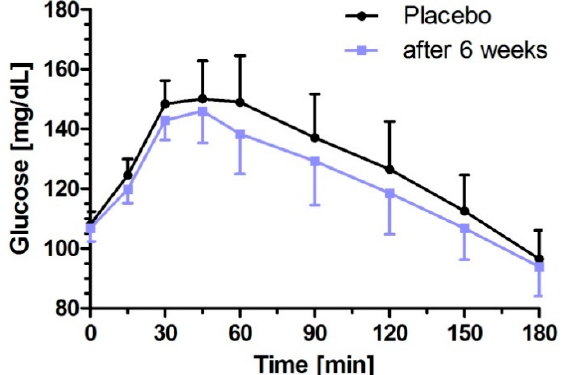
Figure 5. Distribution of Matsuda index ( a ) and of HbA 1c [%] values ( b ) after the six week intervention period with low dose milk protein hydrolysate containing bioactive milk peptides. Data represent mean ±95% CI. Statistical difference as indicated: * p < 0.05.